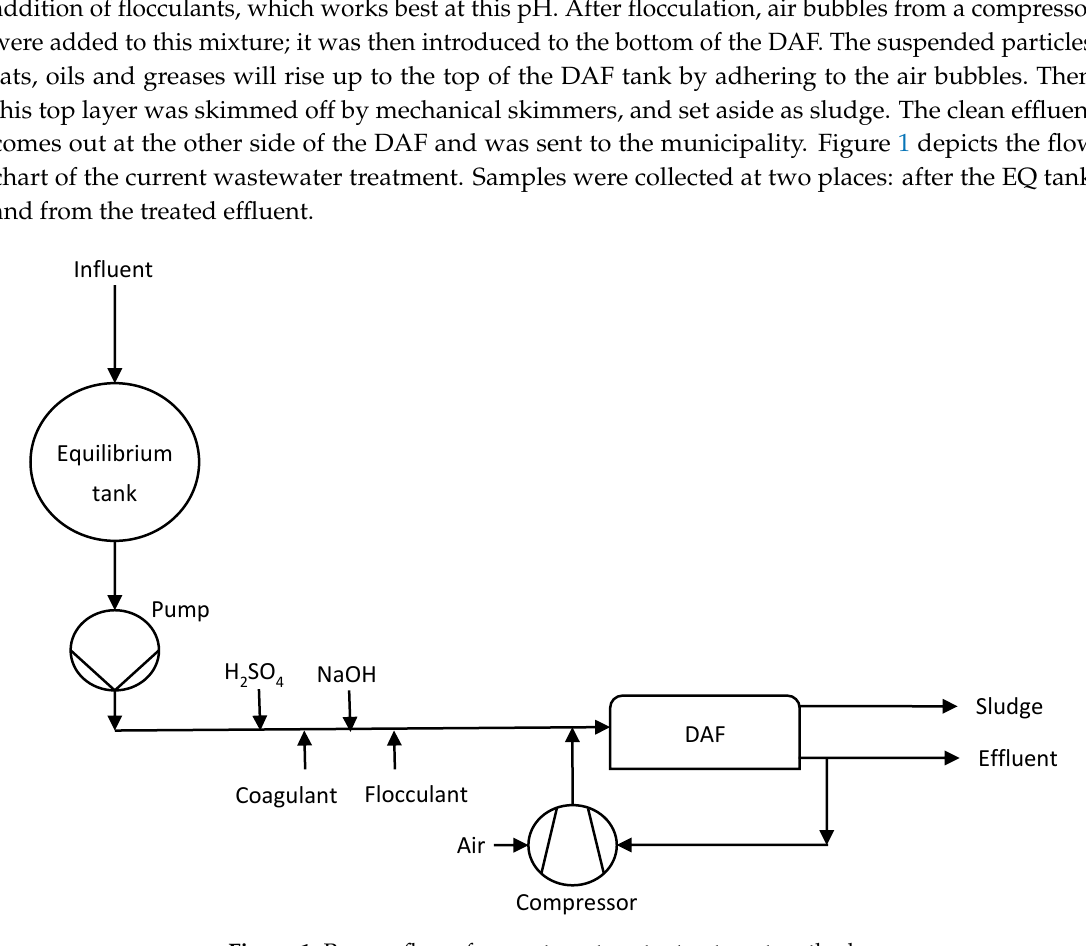
Figure 1. Process flow of current wastewater treatment F igure 1. Process flow of current wastewater treatment method.